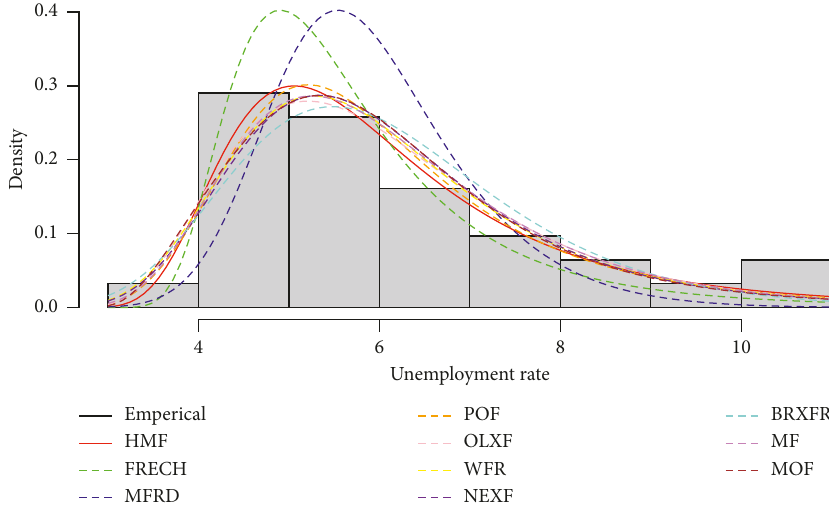
Figure 5: Fitted PDFs for annual unemployment rate dataset.